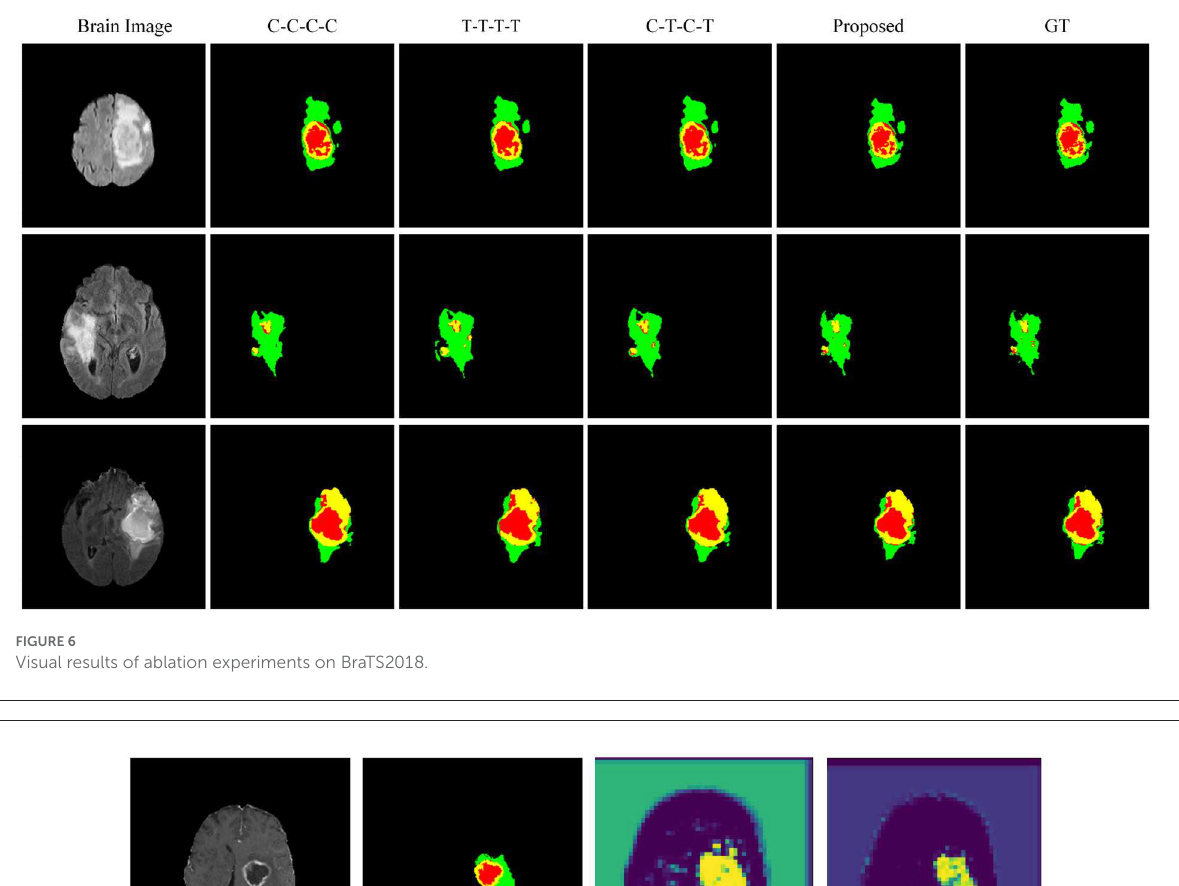
FIGURE7 Performance comparison before and after adding TSEM.